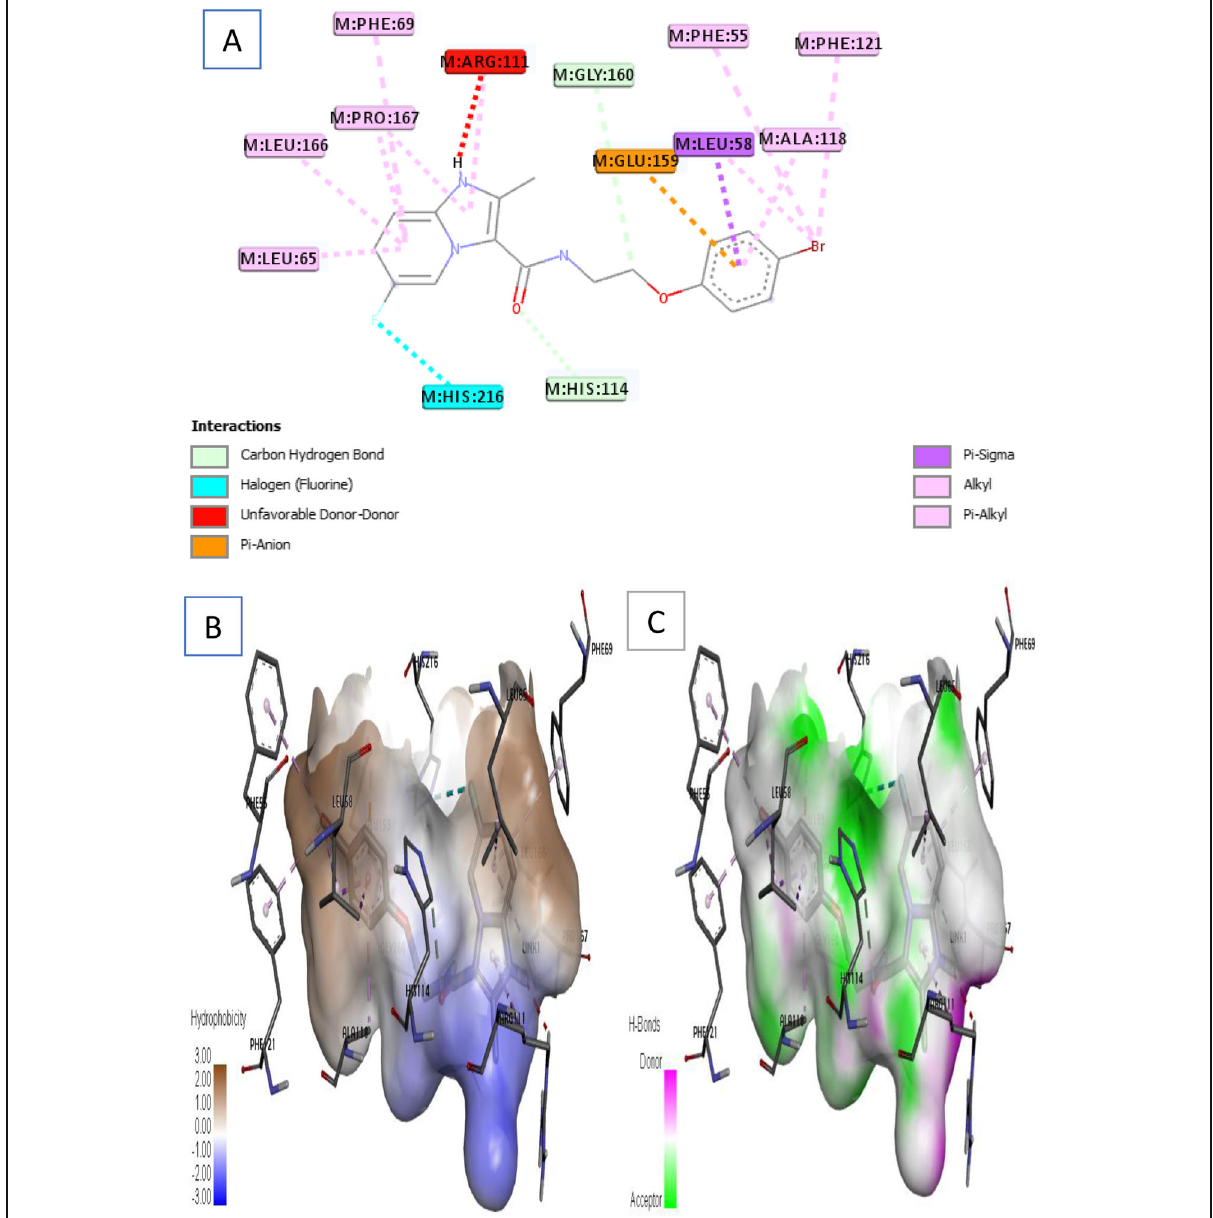
Fig. 6 Docking interactions of complex 2. a 2D docked view of complex 2. b Hydrophobicity surfaces of complex 2. c Hydrogen bond interactions of complex